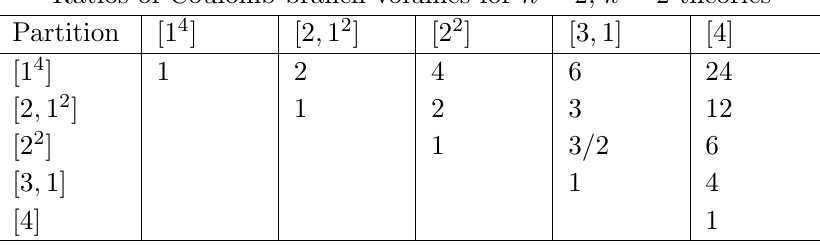
Table 2 . Ratios of Coulomb branch volumes for n = 2, k = 2